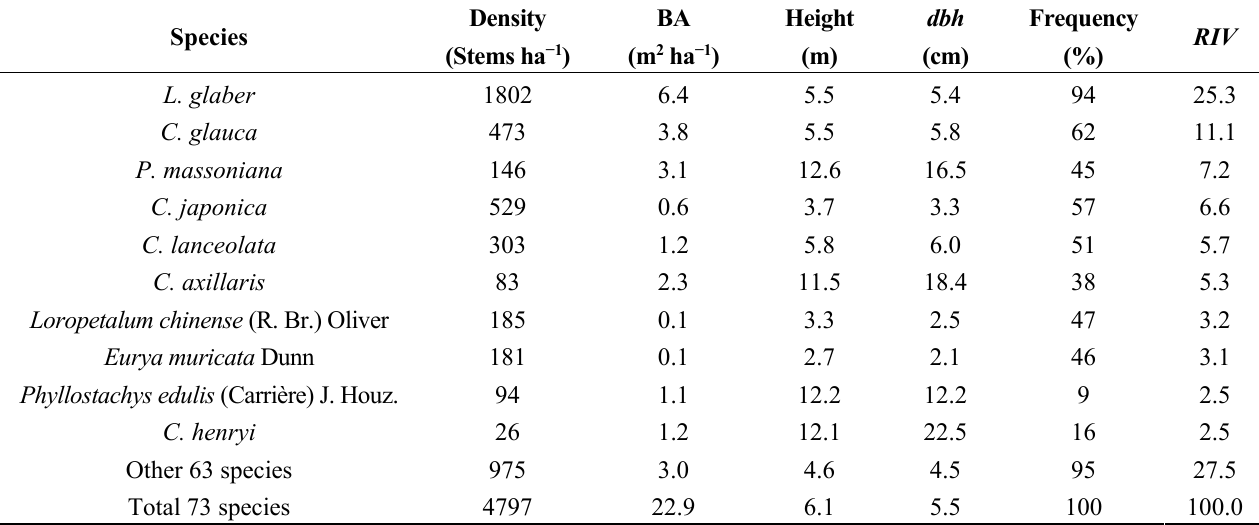
Table 1. Density, basal area (BA), height, average diameter at breast height ( dbh ), frequency, and relative important value ( RIV ) of ten dominant species with a dbh ≥ 1 cm in a 1 ha evergreen broadleaved forest in China.